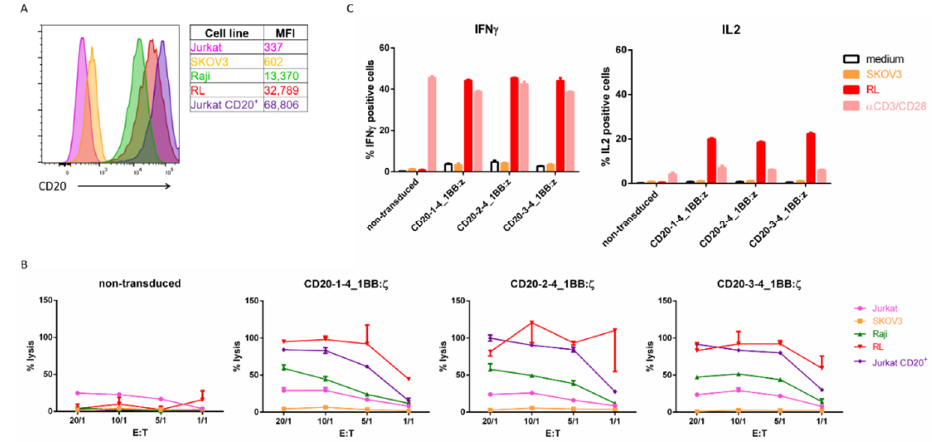
Figure 5. CD20 specific nanoCARs are functional: ( A ) CD20 surface expression on different target cell lines by flow cytometry. MFI represents median fluorescence index; ( B ) Cell lysis of CD20 + or CD20 - target cells 4 h after co-incubation with T cells expressing CD20 nanoCAR in different effector-target ratios. Reported values are the means of duplicate determinations with error bars indicating the standard error the mean (SEM); ( C ) Cytokine production of nanoCAR T cells was analyzed by intracellular staining 5 h after of co-incubation with CD20 + or CD20 - target cells. Mean percentages of IFN-γ and IL-2 positive cells are shown, gated on eGFP + cells. Error bars indicate the SEM. Each experiment shown was performed two times with three different donors. Data shown are representative for these experiments.